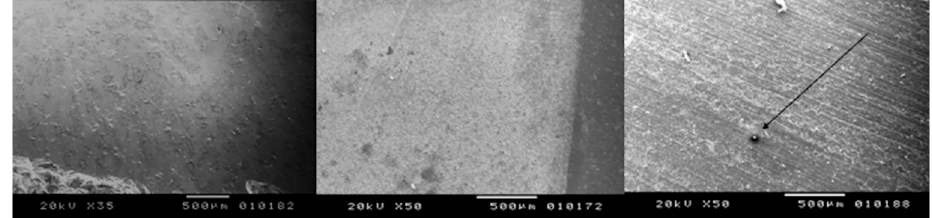
Figure 2. ( Left ) Non-irradiated sample; ( centre ) Peak power of 7.5 kW and 50 mm/s speed; ( right ) Peak power of 7.5 kW and 10 mm/s speed with a carbonization spot (( left ) X35; ( centre , right ): X50).